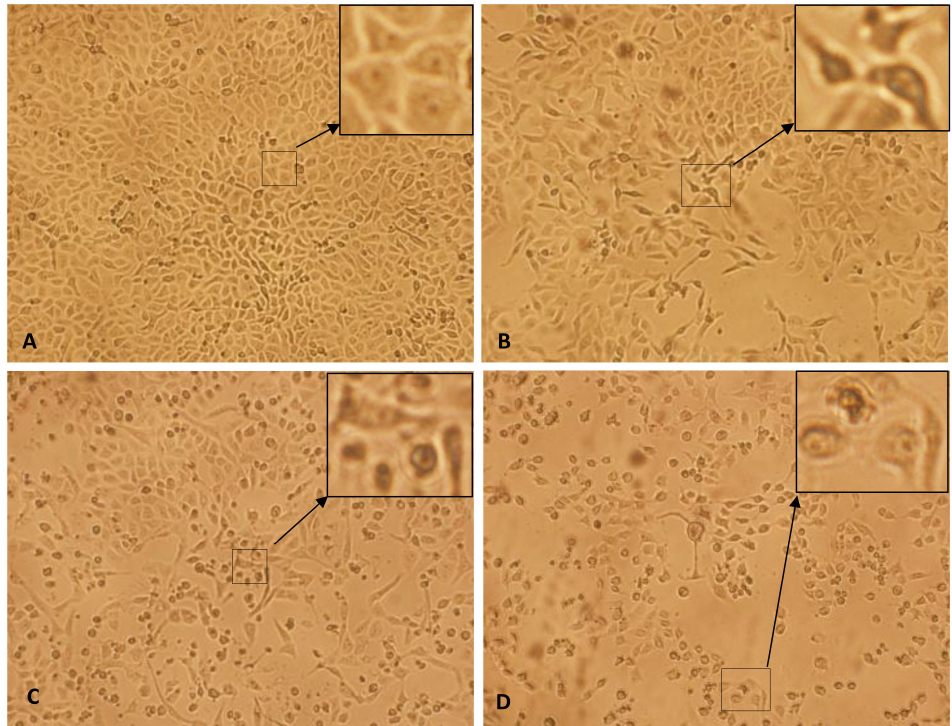
Figure 7. Inverted microscopic images displaying the morphological alterations of HepG2 cells in a time- and dose-dependent manner after exposure to different concentrations of SMAgNPs for 24 h. ( A ) Control cells, ( B ) 20 µ g/mL ( C ) 40 µ g/mL, ( D ) 60 µ g/mL. (Magnification: 100 ×